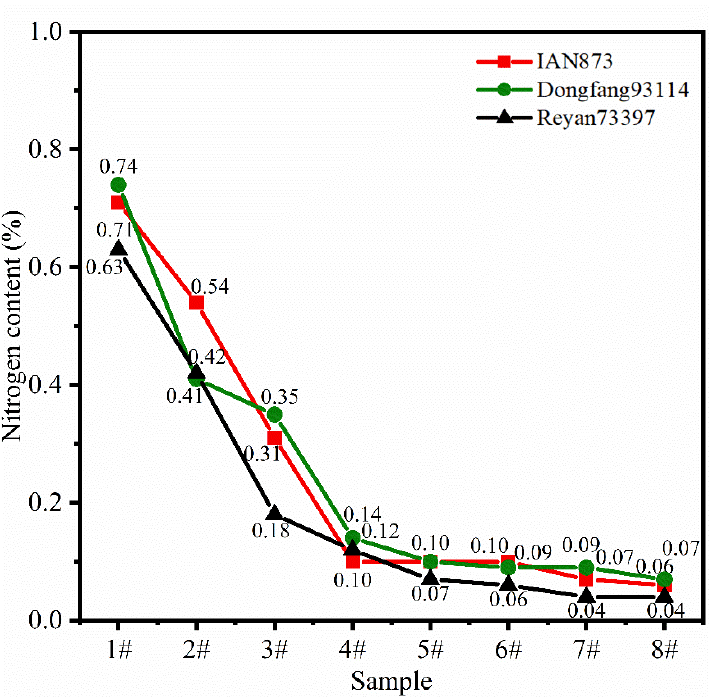
Figure 6. Nitrogen content of rubber films obtained from separated latexes of different Hevea brasiliensis clones.